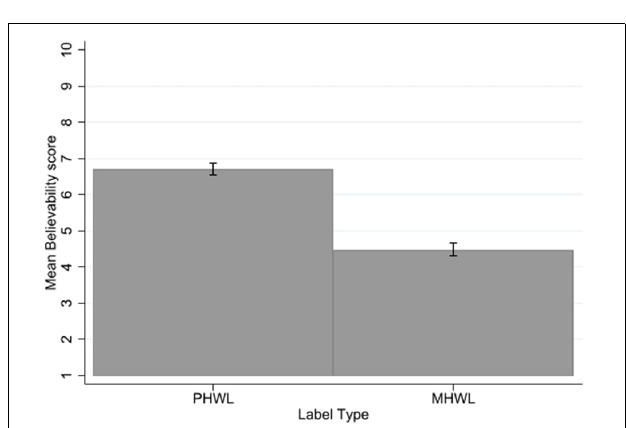
FIGURE 3 | Believability by label type. Error bars represent 95% confidence intervals.